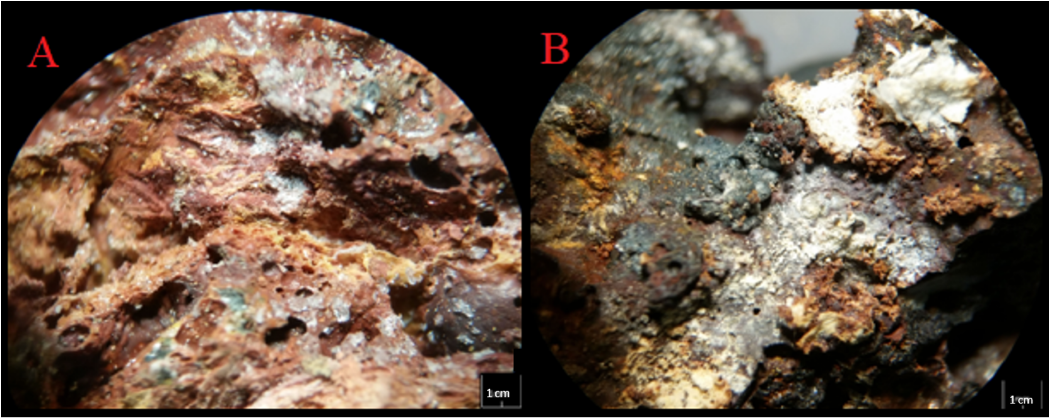
Figure 4. Examples of binocular magnifying glass microphotographs showing slag from the heap with visible enamel fragments ( A ) and precipitates ( B ). In the slag material, pyroxenes and melilites can be identified, which were formed by annealing processes on the material. Glaze samples have a radial texture, resulting from devitrification processes and the presence of crystallites. They are highlighted by the presence of hematite and goethite, forming rims around the slag glaze. These minerals also surround the ore grains (galena, sphalerite, pyrite). The void zones contain secondary minerals classified as sulfates and oxides that form druse, radial structures, filling the voids in question (Figure 5). These minerals crystallized due to the migration of aqueous solutions, penetrating the material in question. Figure 5. Microphotographs of slags with visible devitrified glaze ( A ) and iron oxides and hydroxides located in the background of the glaze and voids ( B ). The micro-area studies were directed at tracing the phases involved in glaze devitrification, as well as identifying ore minerals and derived products associated with the migration of meteoric water in the slags in question. These studies have identified a certain diversity in these substances. Metals such as Zn and Pb with admixtures of Cu; Ti; and also Ni, As and Cd were found in these samples. Silicates were found in the glaze; they also formed their own phases, such as pyroxene and melilite. They were also accompanied by zinc silicates such as wilemite. In the case of ore minerals, mainly sulfides, such as pyrite, chalcopyrite, galena, sphalerite (or wurcite), were found, which were concentrated in the form of intrusions and epidotes within the slags (Figure 6). In